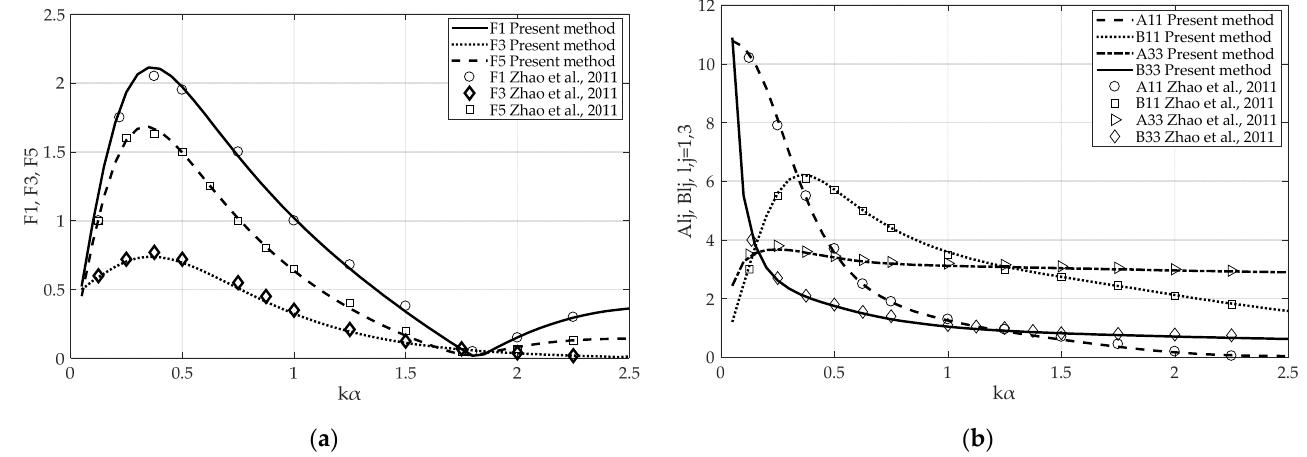
Figure 3. Comparison of the present analytical results with Zhao et al. [32] in terms of ( a ) dimen- sionless exciting forces F 1 ,F 3 , F 5 and ( b ) dimensionless hydrodynamic coefficients A 11 ,B 11 , A 33 ,B 33 . Here, 𝐺 = 1.432 .